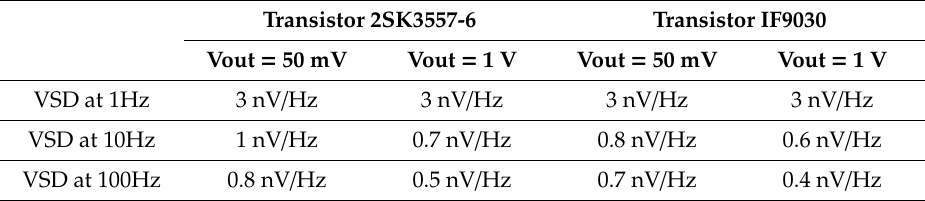
Table 2. Noise performances of the constructed low-noise voltage